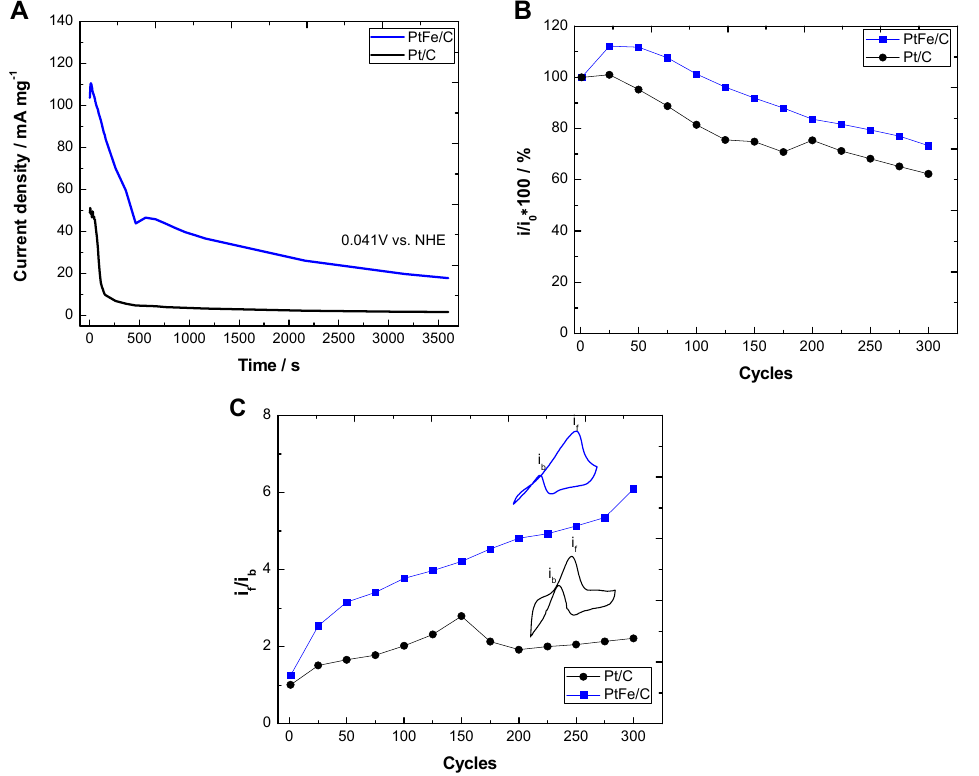
Figure 7. ( a ) Stability tests for Pt/C and PtFe/C by chronoamperometry using 0.041 V vs. NHE as the fixed potential for 1 h; ( b ) Losses in activity comparing the peak current densities in the forward scan, where I 0 corresponds to the peak current density of cycle 1; ( c ) Changes derived from the adsorption of poisoning species calculated from dividing the peak current density of the forward scan by the peak current density of the backward scan.